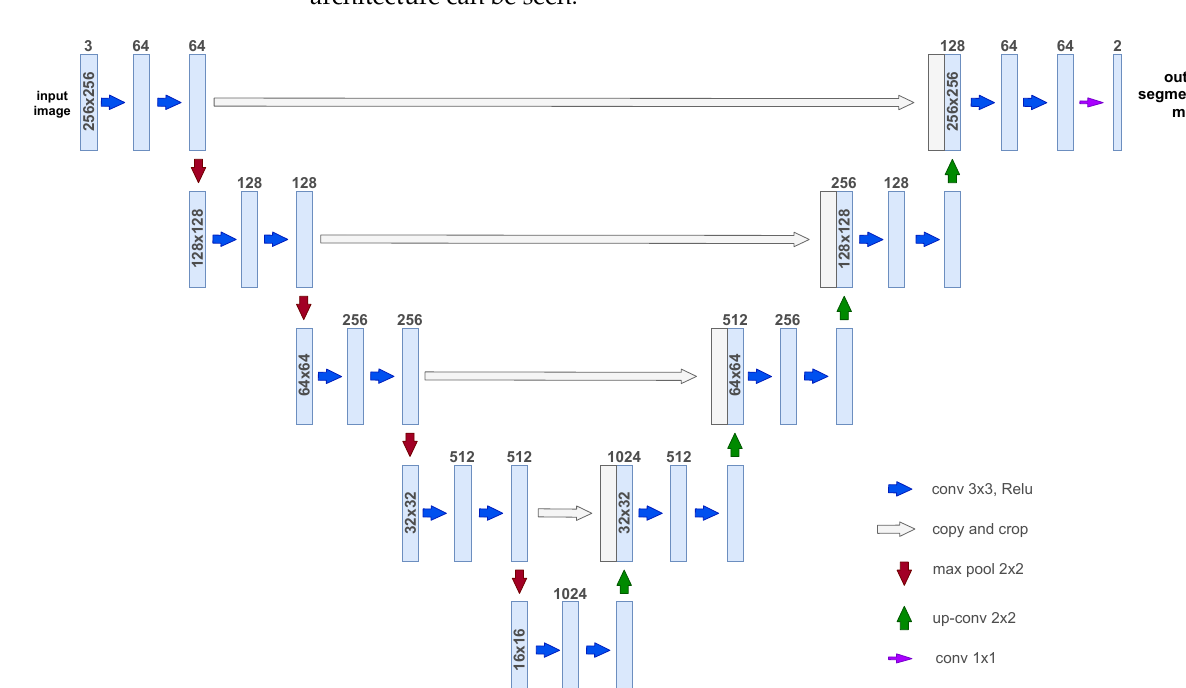
Figure 5. UNet architecture. This diagram is based on the original UNet publication